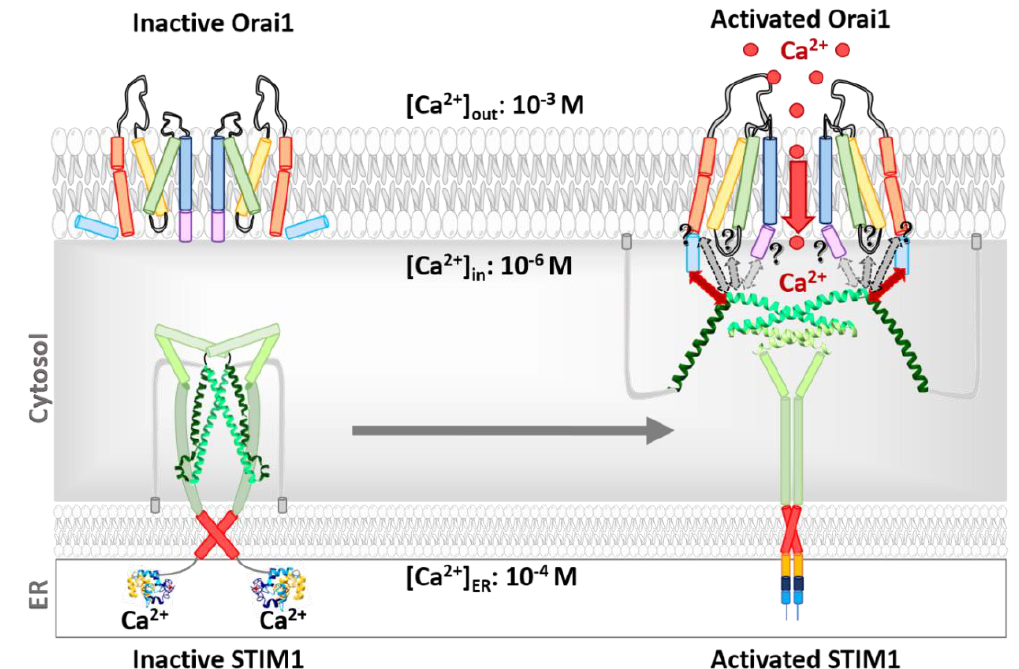
Figure 5. Activation mechanism of the STIM1 / Orai signaling machinery. The scheme visualizes STIM1 and Orai1 in the resting state ( left ) and activated state ( right ). Upon STIM1 binding, Orai1 C-terminus is proposed to extend ~45 Å into the cytosol ( right ). The main and indispensable coupling sites for STIM1 represent the Orai1 C-terminus. The hinge plate, loop2, and N-terminus of Orai1 are additionally supposed to interplay with STIM1, either directly or indirectly (as indicated by the double-sided arrows and question marks).